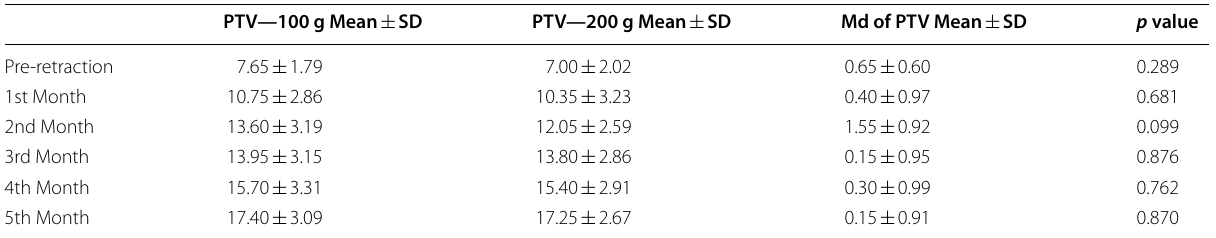
Table 3 Means, standard deviations, the changes in the PTVs prior to canine retraction and monthly till the 5th month regarding the force magnitude and the p value of the independent sample t test